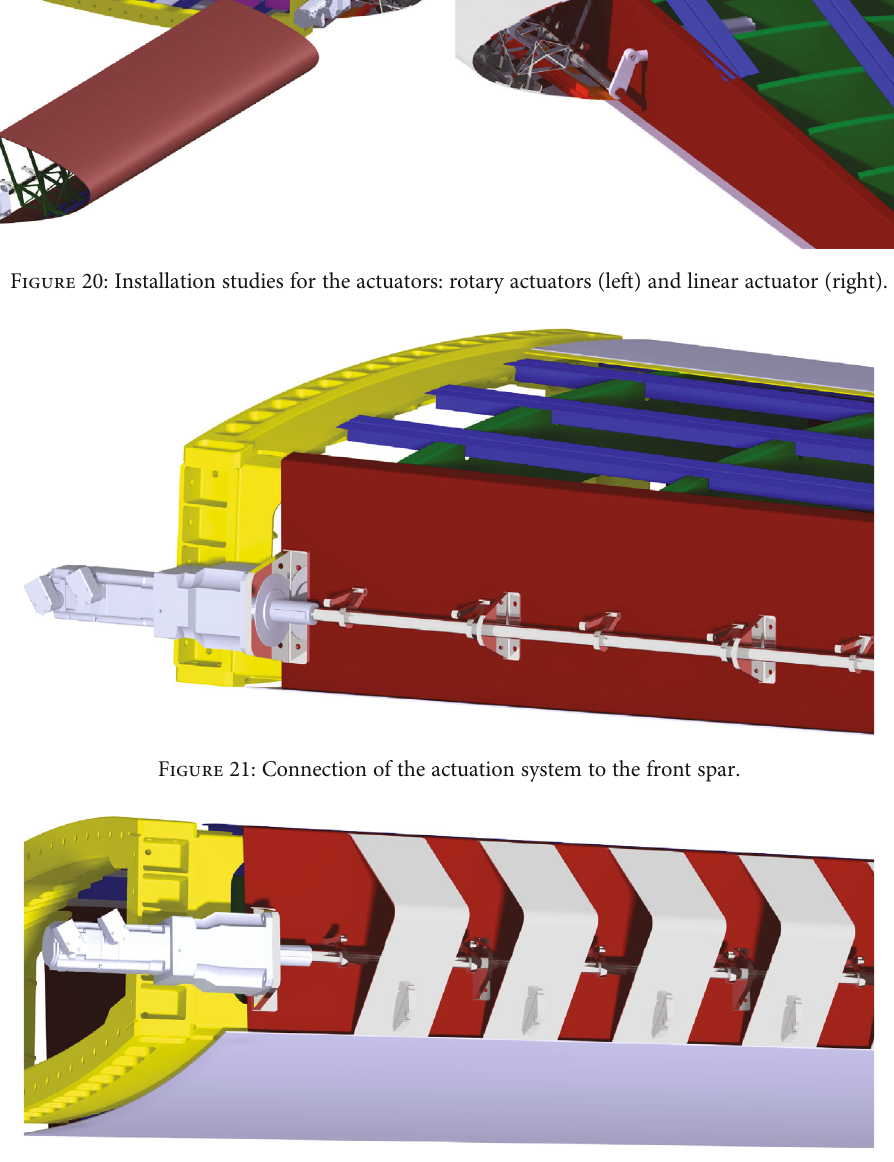
Figure 22: Assembly of the splitters on the front